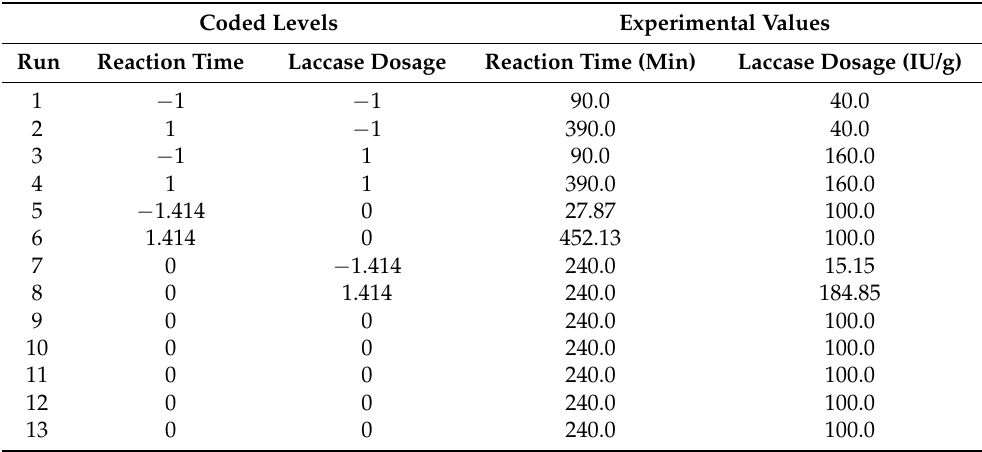
Table 1. Experimental conditions of the central composite design for investigation of kraft lignin polymerization by SiLA and MtL laccases considering two input variables (laccase dosage and reaction time) at three levels ( − 1, 0,